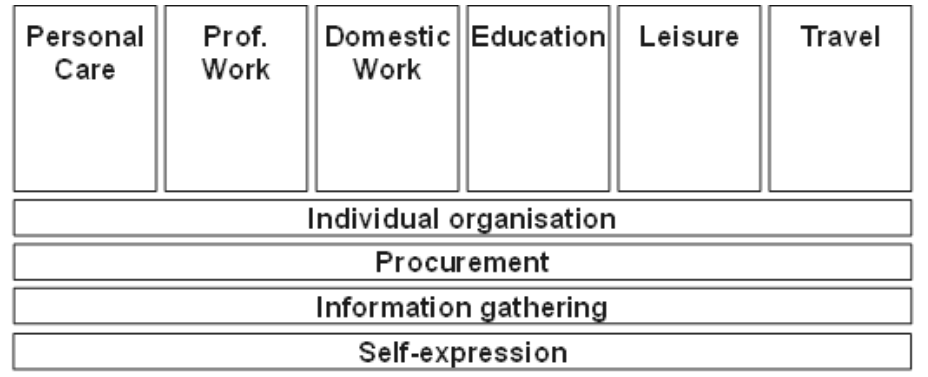
Figure 1. Generic Individual Value Chain